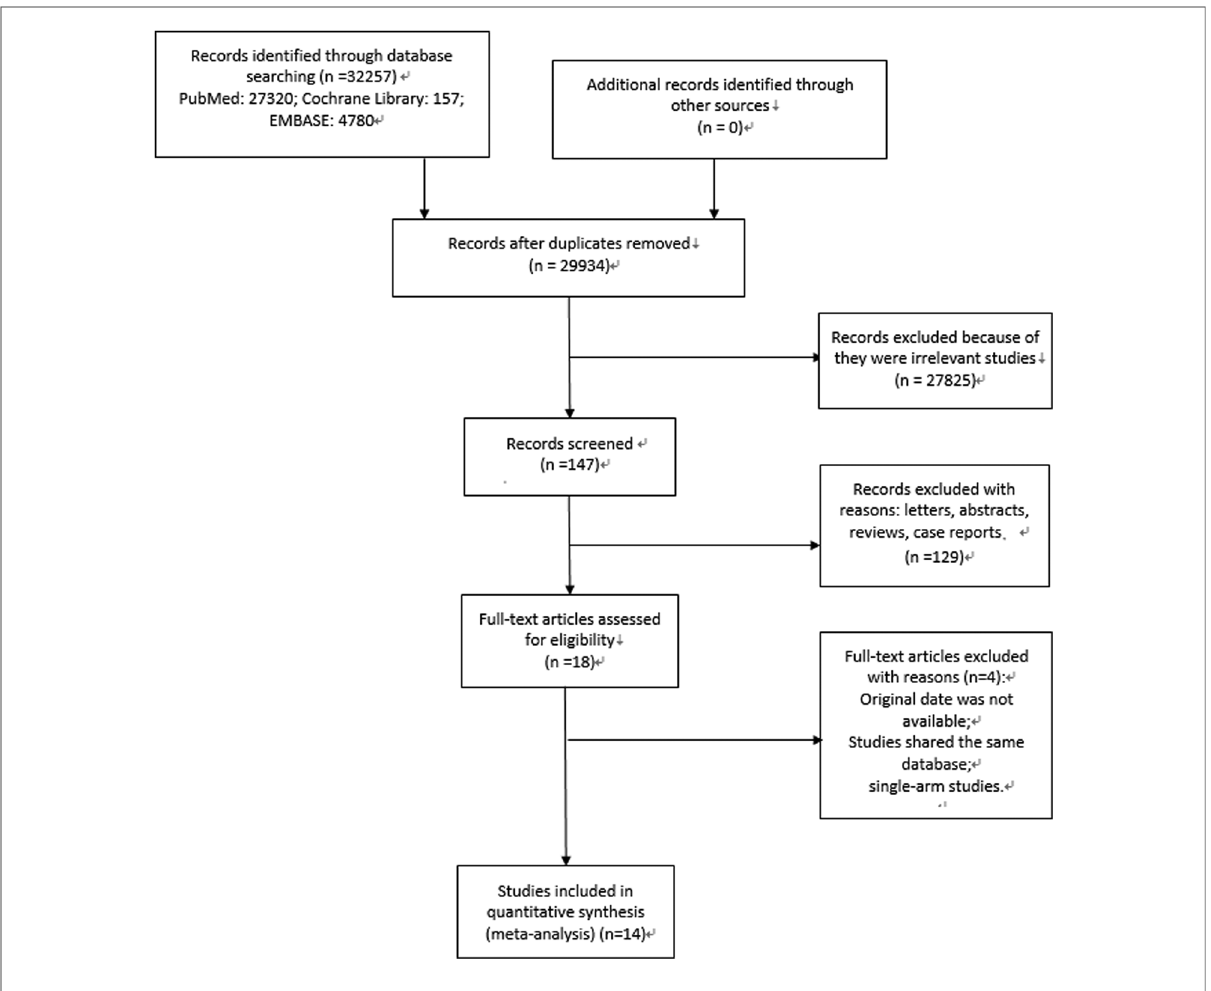
FIGURE 1 Speci fi c process of literature researching and